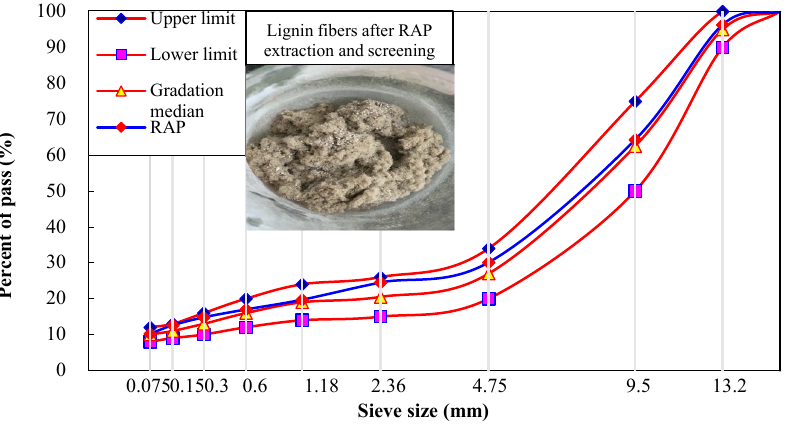
Figure 9. Gradation of RAP.